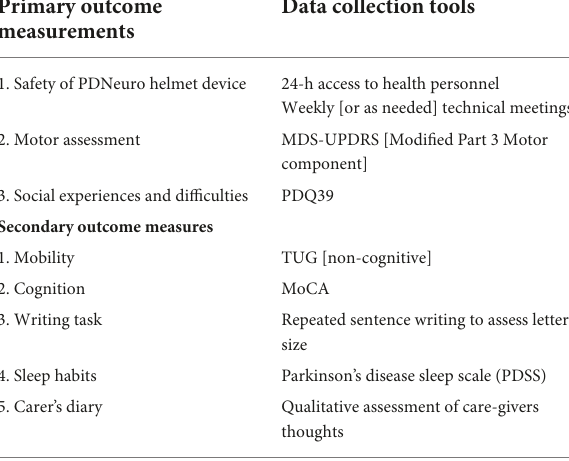
TABLE 1 Outcome